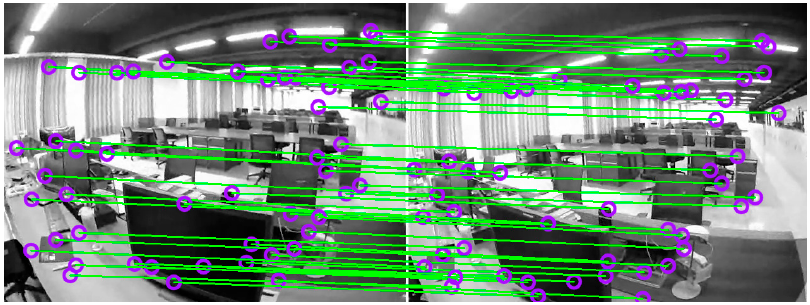
Figure 7. Feature correspondences between the left and right binocular cameras.